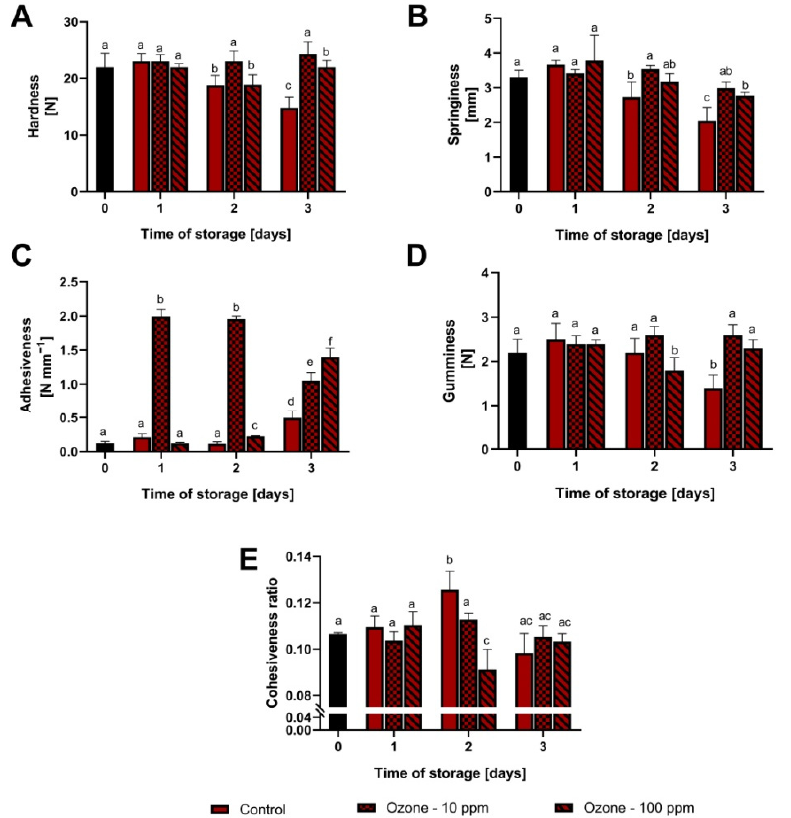
Figure 1. Effect of ozonation process on the texture profile of strawberry fruit during storage at room temperature. ( A ) fruit hardness; ( B ) fruit springiness; ( C ) fruit adhesiveness; ( D ) fruit gumminess; ( E ) fruit cohesiveness. Mean values with standard error (error bars), with the same lower case are not statistically significant according to the t ‐ Tukey test ( α = 0.05).